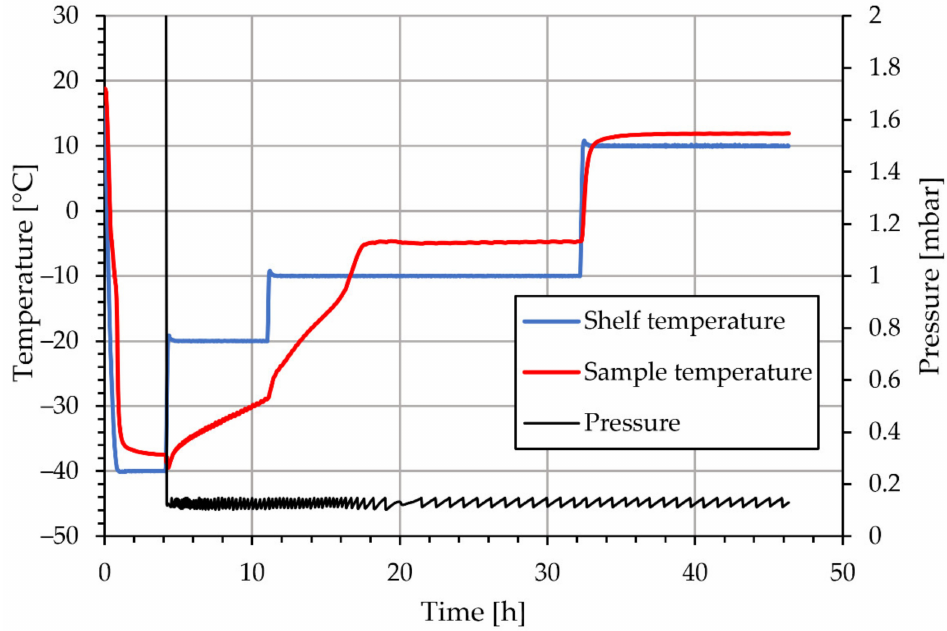
Figure 2. Lyophilisation protocol, shelf temperature, sample temperature and the pressure inside the lyophilisatior for Ni/Y 2 O 3 nanocomposite